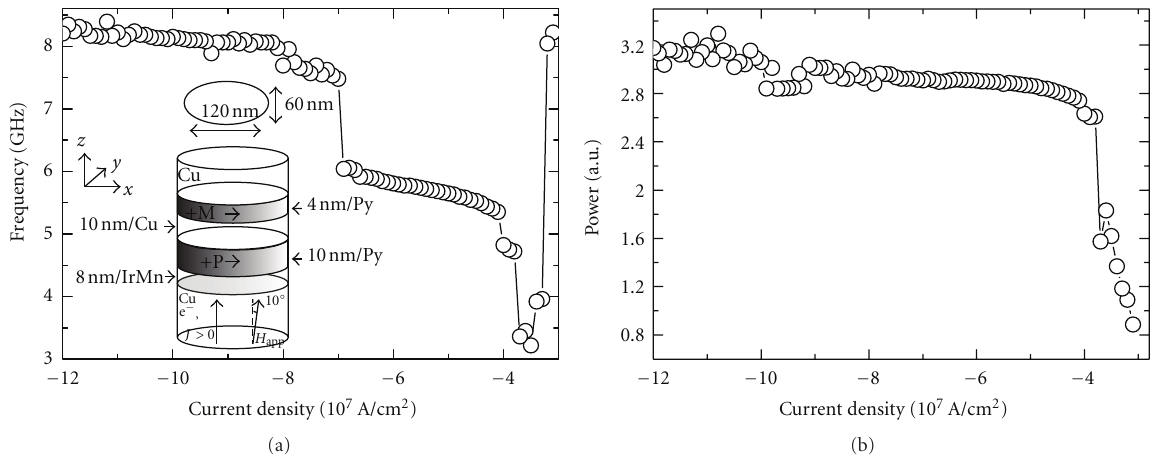
Figure 1: (a) Frequency and (b) power amplitude versus dc current density when an out-of-plane field of 250 mT tilted 10 ◦ versus x - directionis applied. No microwave source is applied. Inset of (a): sketch of the